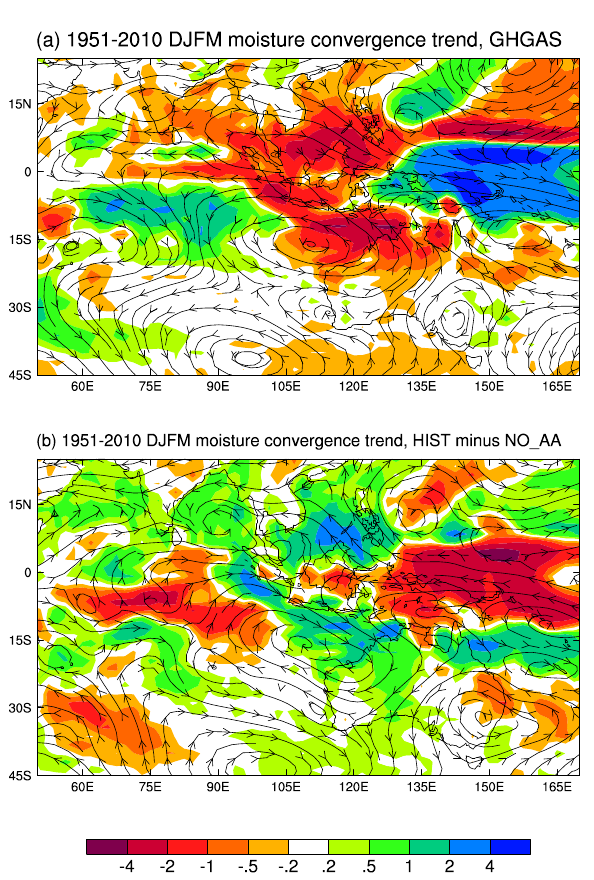
Fig. 18. Simulated 1951–2010 DJFM trends in moisture conver- gence (shading, in mmday − 1 century − 1 ) and moisture transport (streamlines), for (a) GHGAS, (b) HIST minus NO